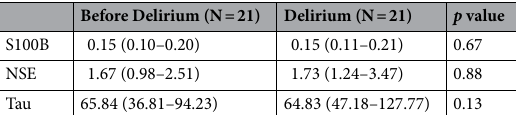
Table 4. S100B, NSE and Tau before and during